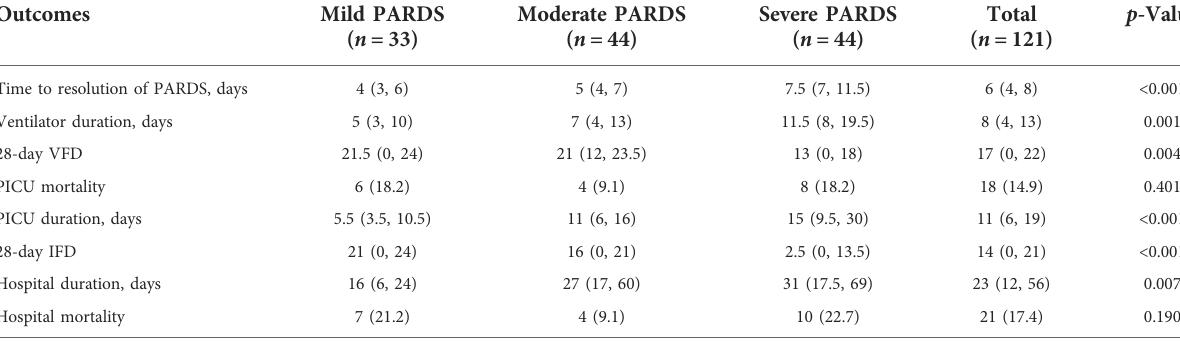
TABLE 2 Short and intermediate term outcomes in patients with pediatric acute respiratory distress